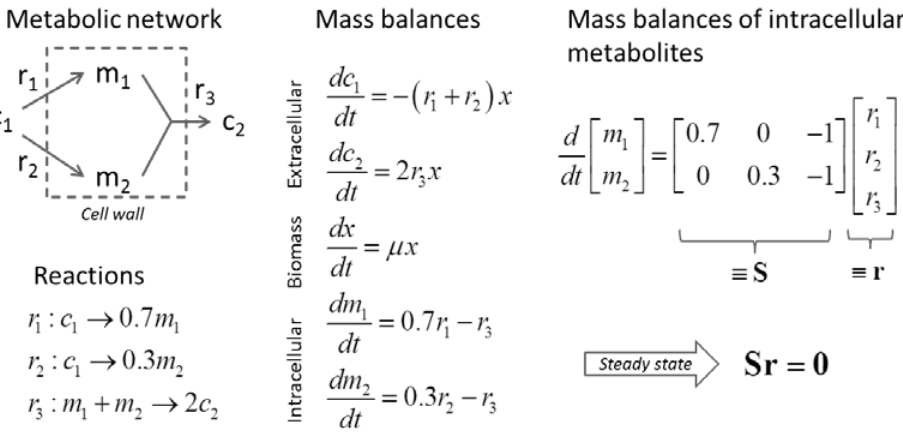
Figure 3. Graphical and mathematical representations of metabolic reactions occurring in a